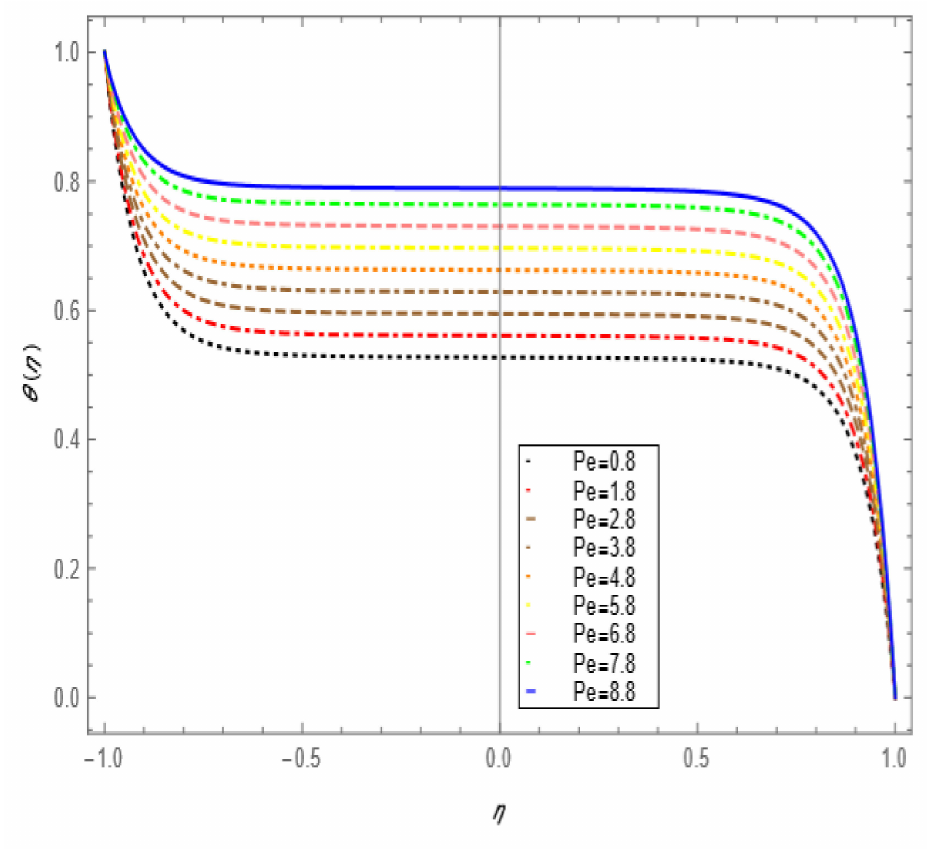
Figure 7. Temperature profile effect size for = 0.1, Re = 1.5, M = 5, ϕ 1 = ϕ 2 = 0.05, Ec = 0.00068, Pr =